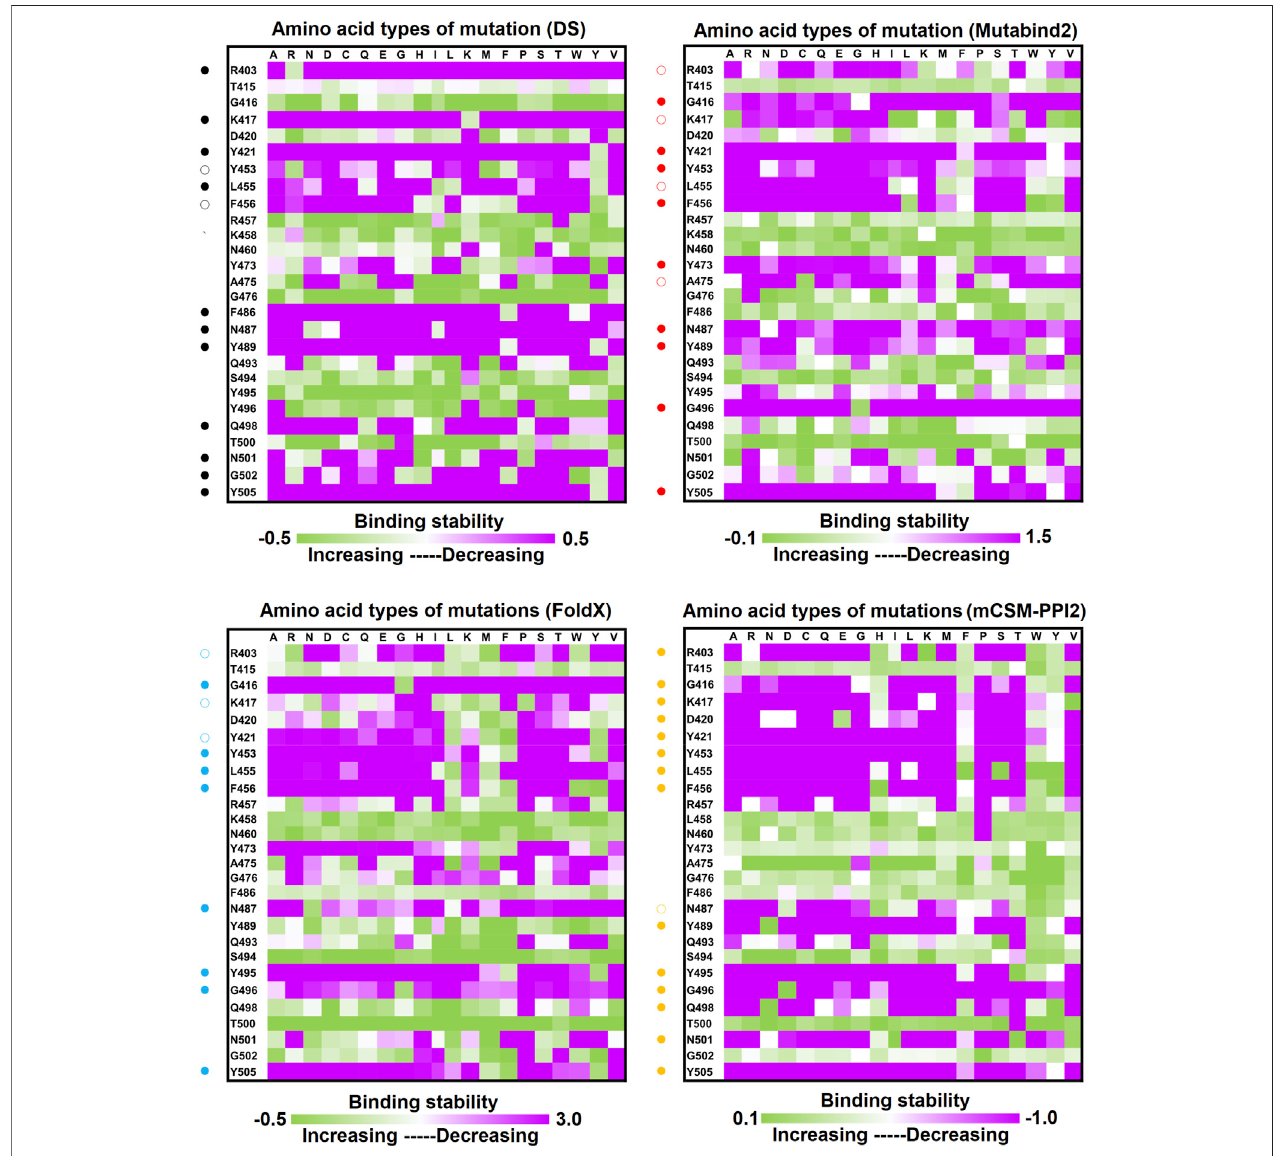
FIGURE7 | Mutationalheatmaps ofRBD targetingantibody CA1-B12. The mutational binding stabilities ofRBD variants toCA1-B12 wereestimated using FoldX, MutaBind2, DS 3.5, and mCSM-PPI2. The unit of binding stability was kcal/mole, and the obtained values were employed to create the heatmaps. Green (increased stability) and purple (reduced stability) were used to generate a color gradient and were applied in each box. In each heatmap, the moderately and signi fi cantly reduced stabilities were labeled with hollow and solid circles, respectively.